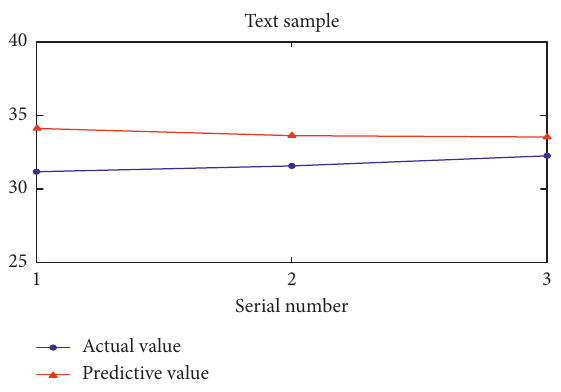
Figure 21: BP network test